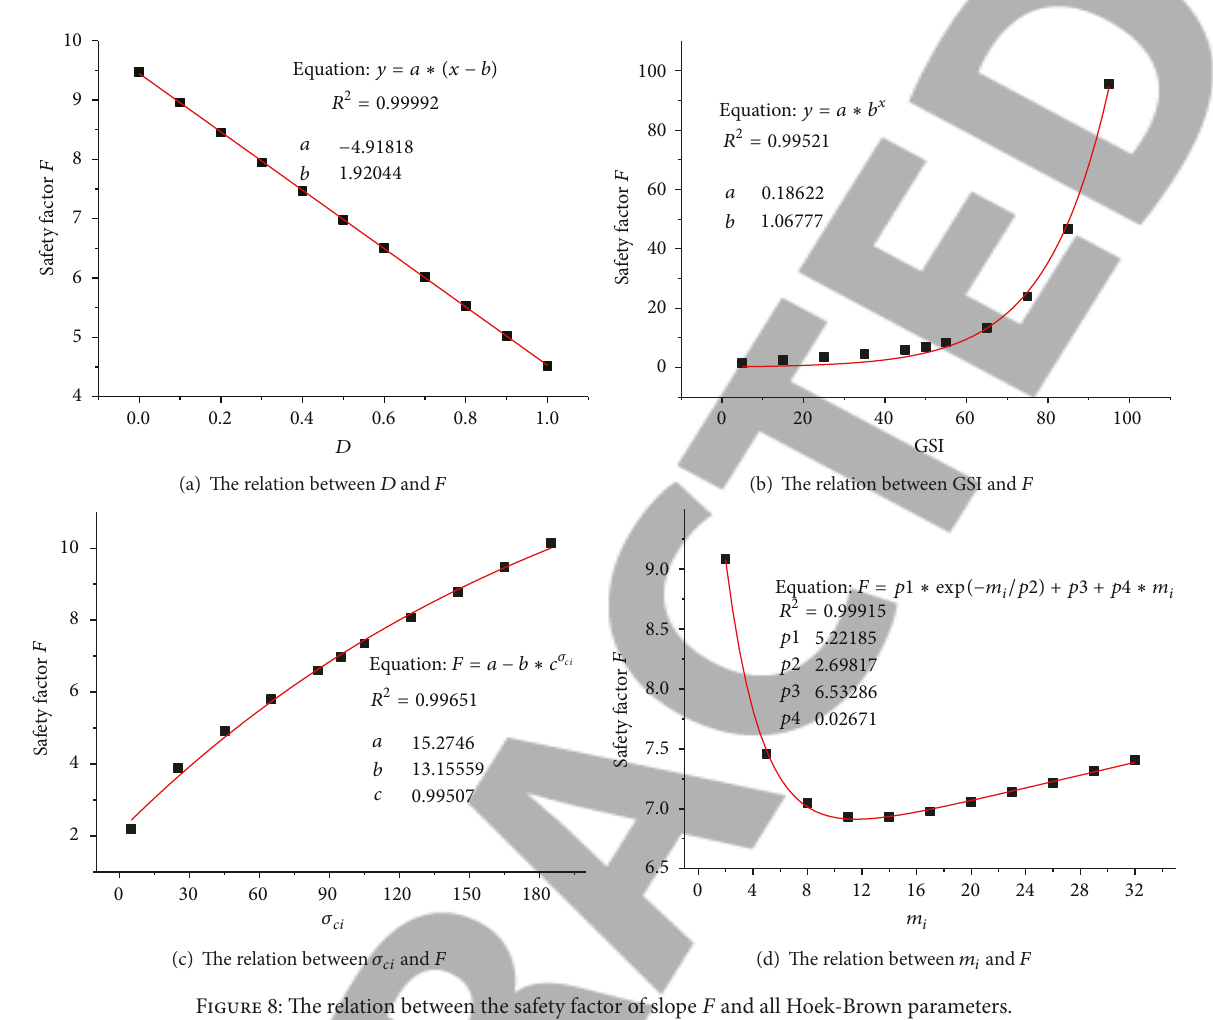
Figure 8: The relation between the safety factor of slope 𝐹 and all Hoek-Brown